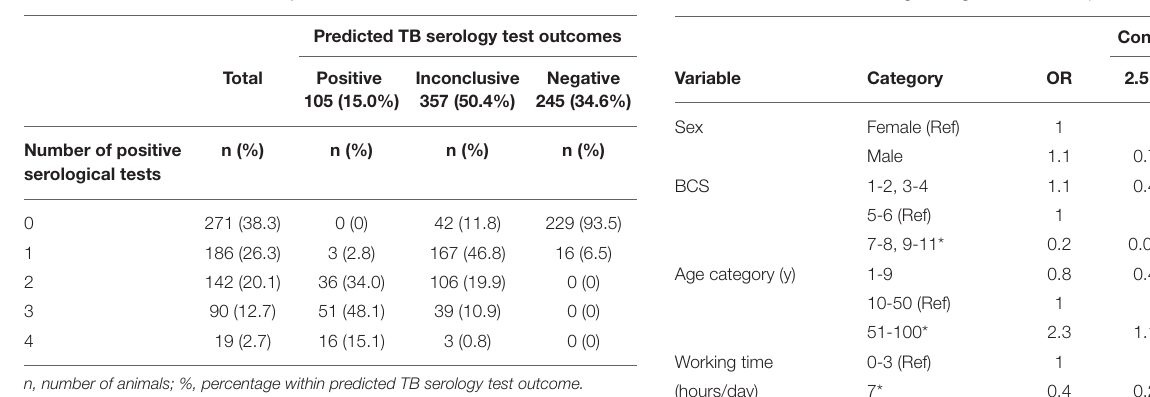
TABLE 5 | Estimates of the strength of association (odds ratio and 95% confidence interval) for positive TB serology test outcome with demographic factors based on univariable logistic regression models per